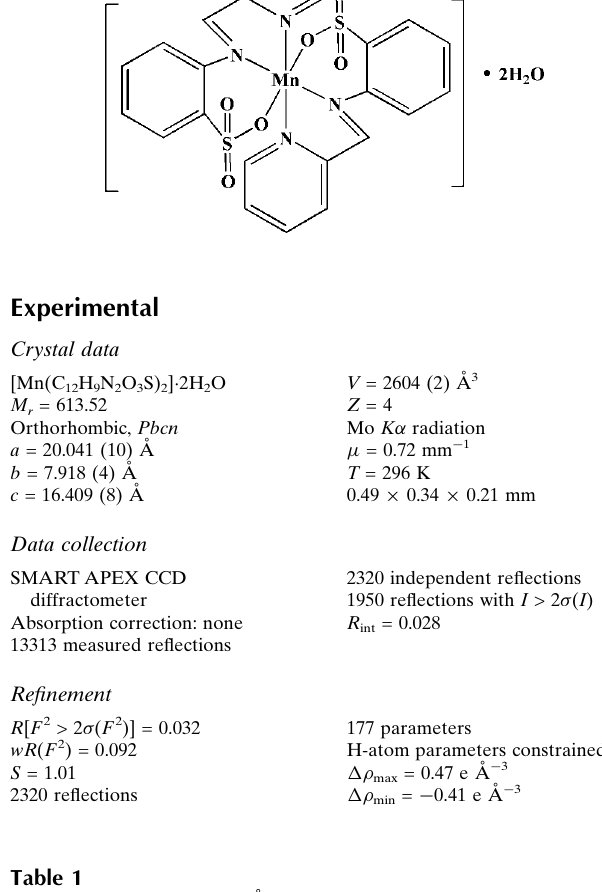
Hydrogen-bond geometry (A˚ , (cid:5)